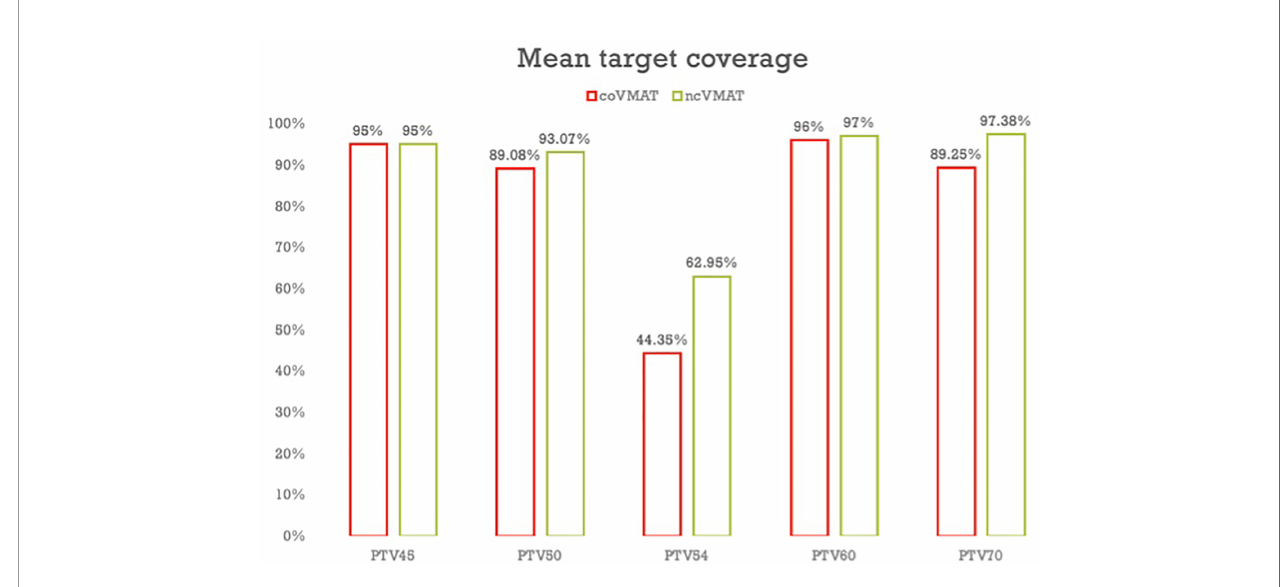
FIGURE 4 | Mean target coverage comparison of coVMAT and ncVMAT